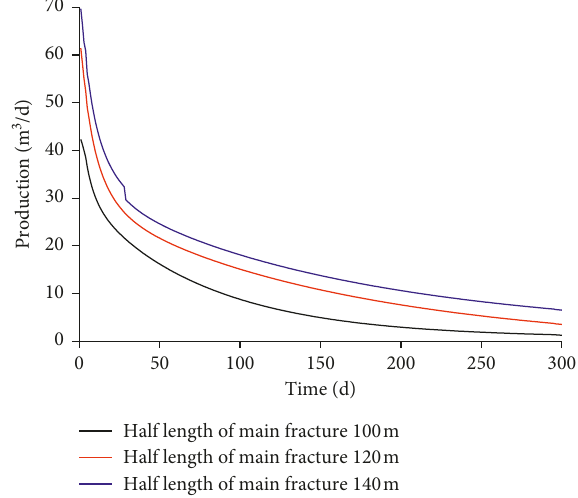
Figure 7: Production at a 300-day period with different half- lengths of main